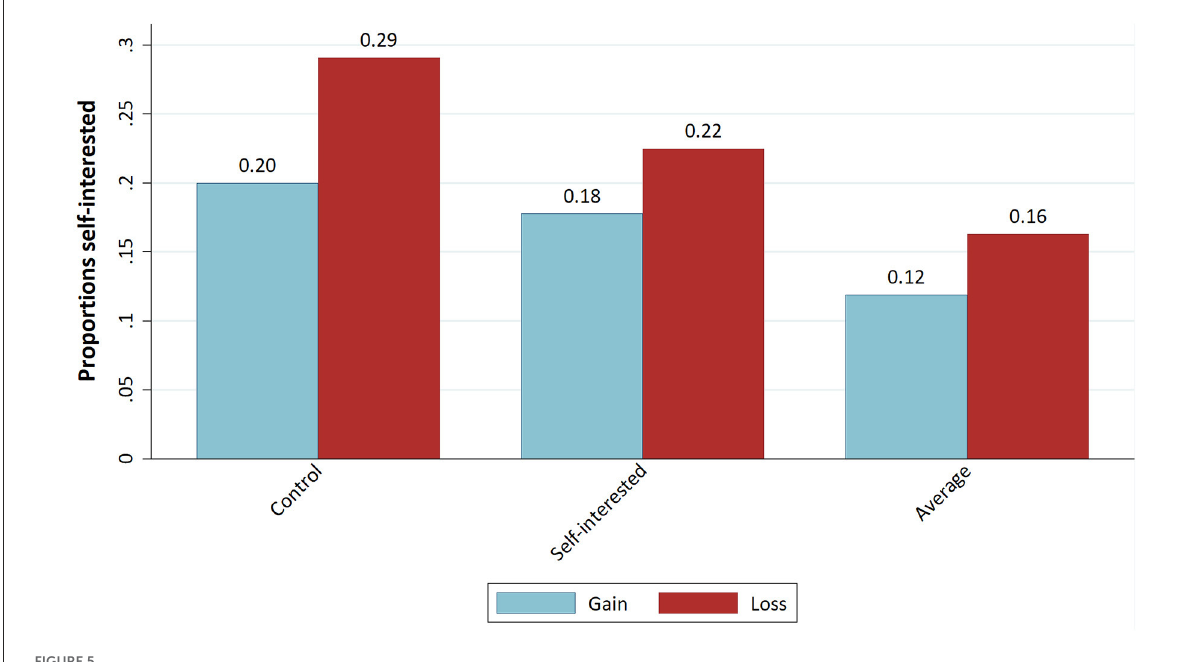
FIGURE5 Proportion of fully self-interested decisions.